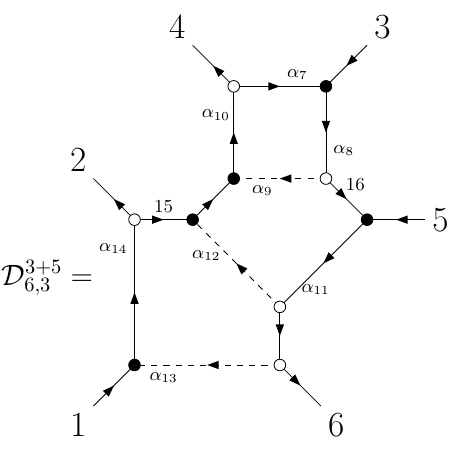
Figure 17 . ‘3+5’ on-shell diagram to be summed over 2 ↔ 4 and 3 ↔ 5 . Edge variables are